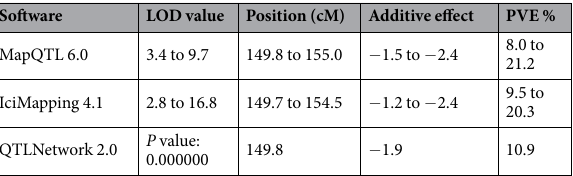
Software LOD value Position (cM) Additive effect PVE %